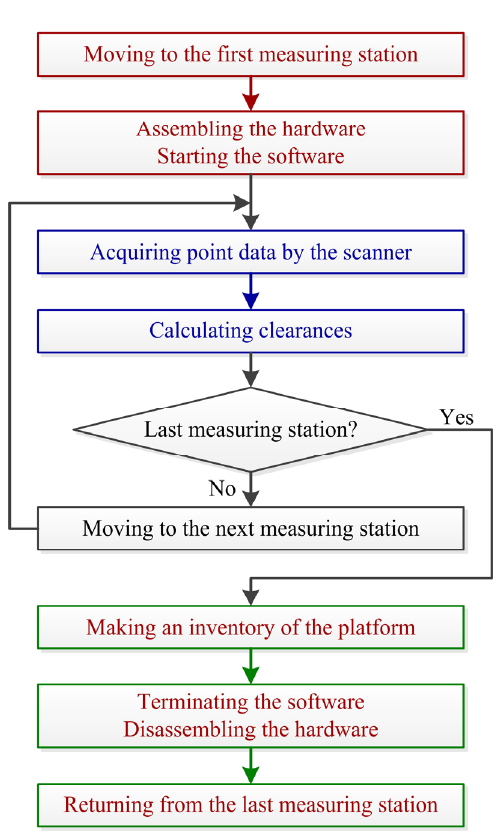
Figure 7. Process of calculating